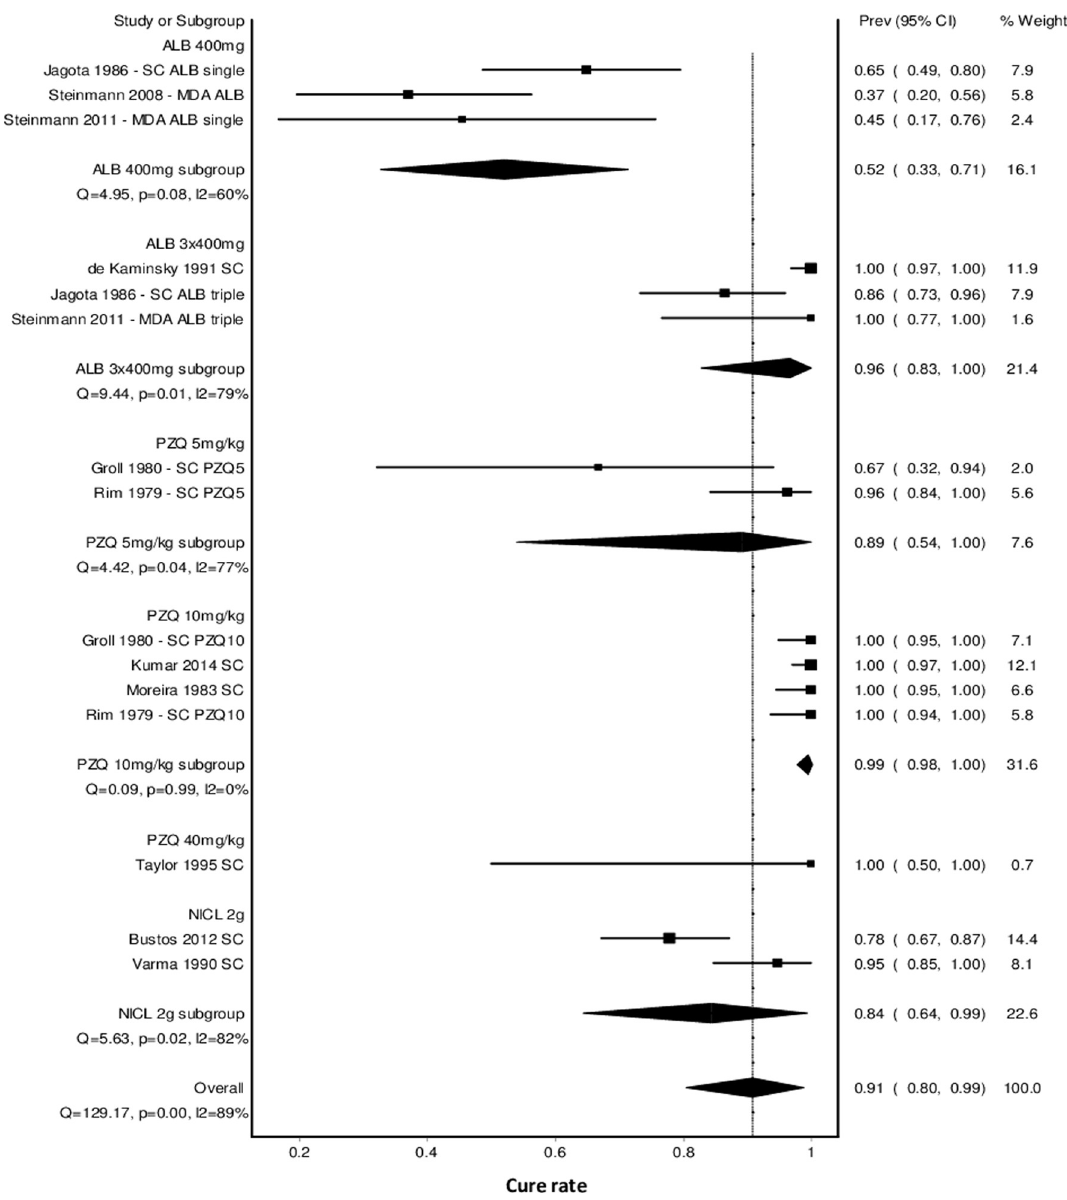
Fig 3. Forest plot showing the effect of preventive chemotherapy with different drugs and doses on the cure rate for T . solium